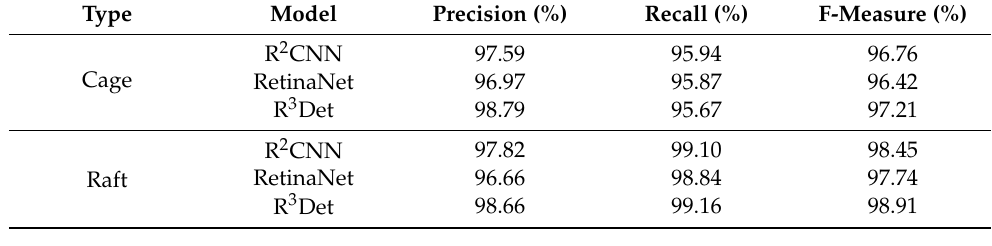
Table 6. Comparisons of extraction accuracy of aquaculture zones using different models.